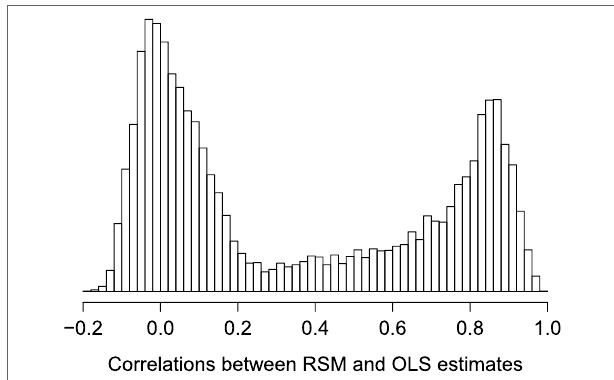
FIGURe 3 | Histogram of the correlations from 10,000 bootstrap samples from the 2012 to 2014 graduation rates in New Mexico between the random slope multilevel and fixed slope (OLS)